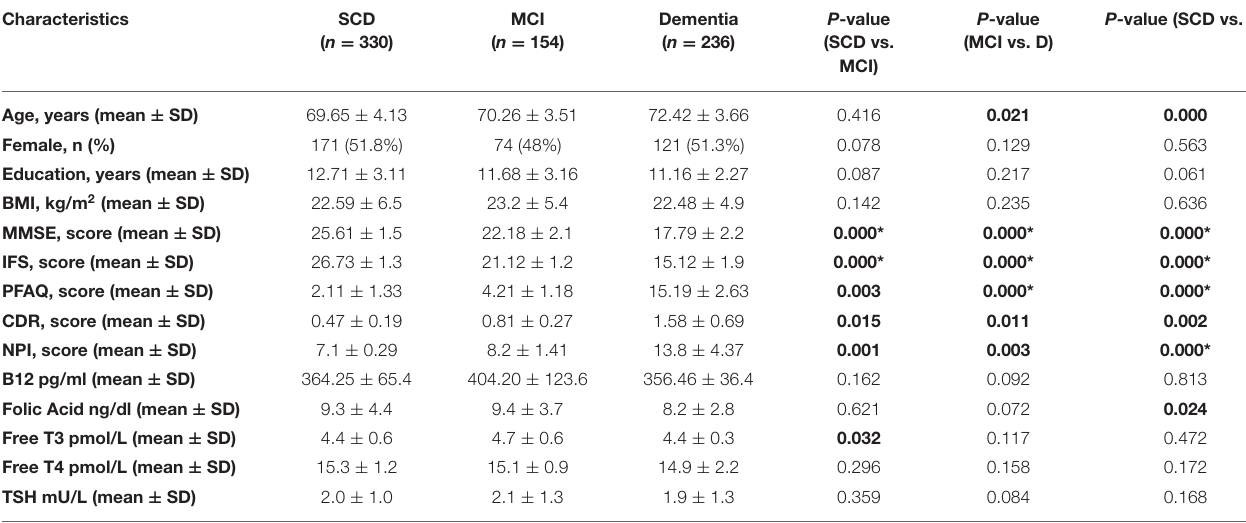
TABLE 1 | Demographic, cognitive, and metabolic characteristics of the sample by cognitive stage ** . Characteristics SCD